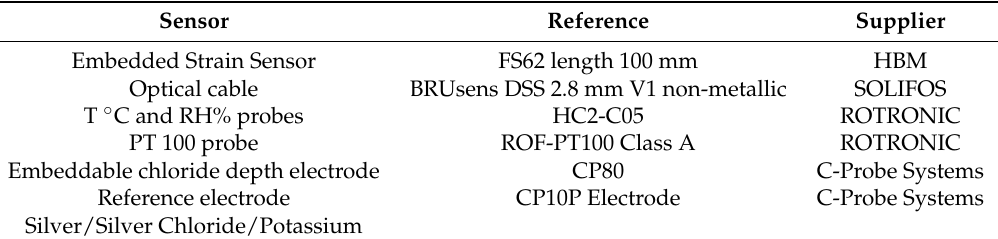
Table A1. Sensor used on site: references and suppliers.